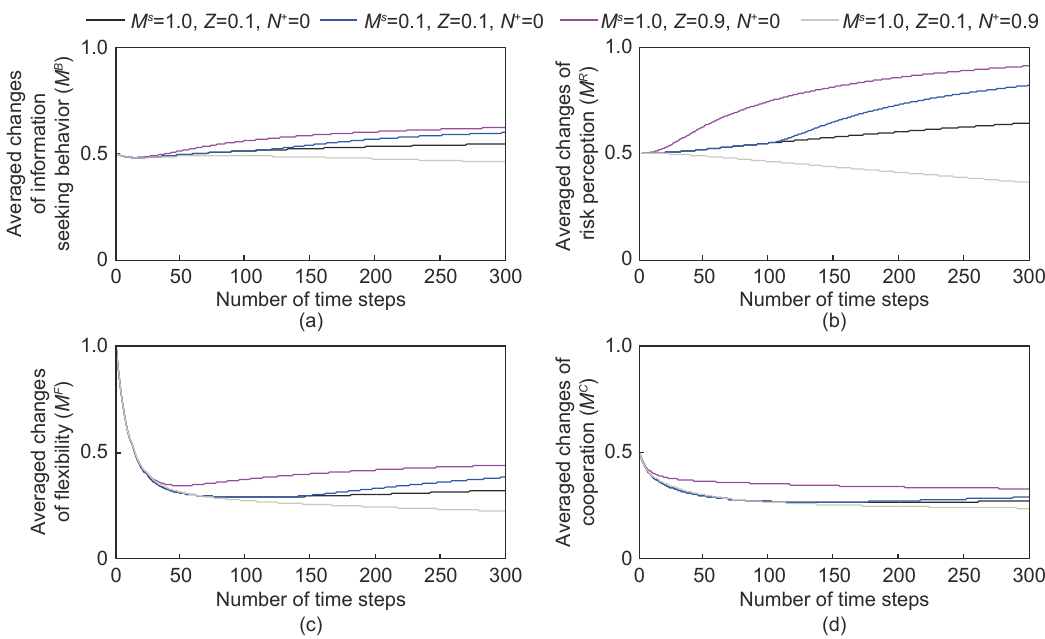
Fig. 7 Effects of the emergency services, the injury factor of disaster, and news polarity on the collective information-seeking behavior, risk perception, flexibility, and cooperation. The black lines represent the effects when the emergency services are entirely available, and the disaster is benign. However, there are a lot of rumors and negative news among individuals. In contrast, the blue lines represent the effects when the emergency services are not available to the community. In the case of the purple lines, the emergency services are wholly available but the disaster is severe, and there are positive news in the society. The grey lines also represent a case when emergency services are available. However, in this case, there are lots of positive news and the disaster is not severe.